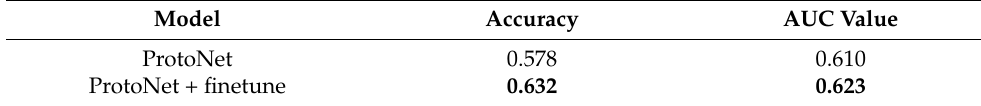
Table 4. Test performance of few shots learning